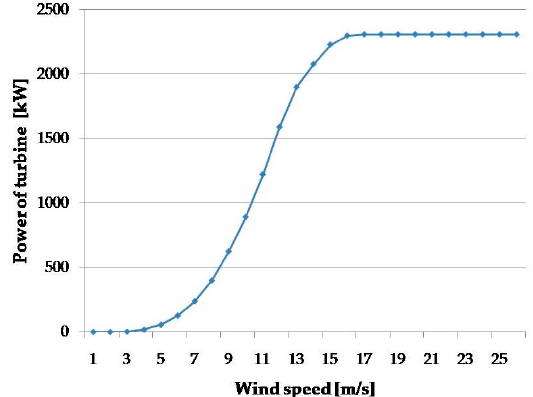
Figure 5. Power characteristics of the ENERCON E-70 turbine as a function of wind speed, own elaboration based on Reference [47].